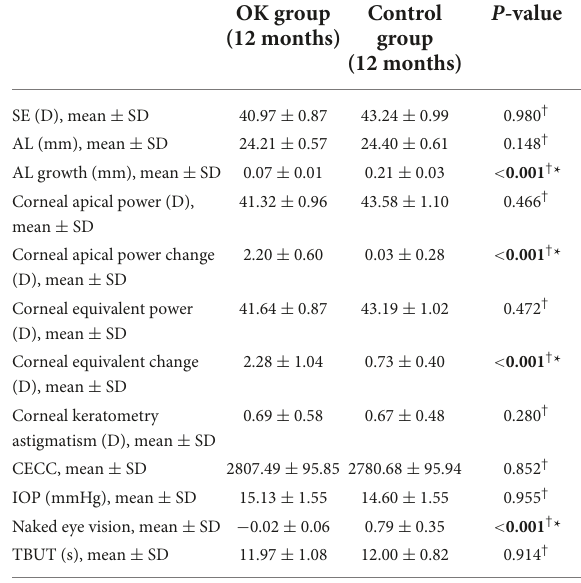
TABLE 2 Ophthalmology examination between the orthokeratology (OK) group and control group after 12